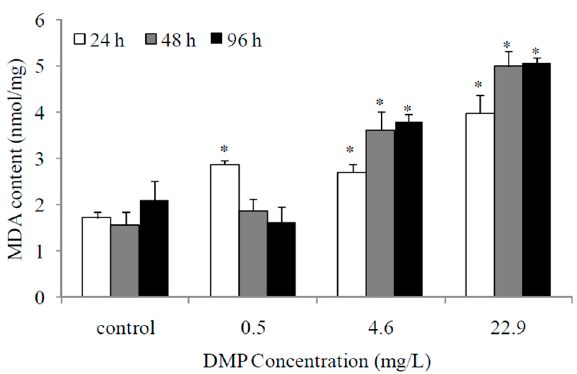
Figure 2. DMP-induced lipid peroxidation levels in zebrafish. Adult fish were exposed to 0.5, 4.6 and 22.9 mg / L DMP for 24, 48, and 96 h. Error bars represent the standard deviation. Significant di ff erences from the control are indicated by an asterisk, which is based on Student’s t -test ( p < 0.05).